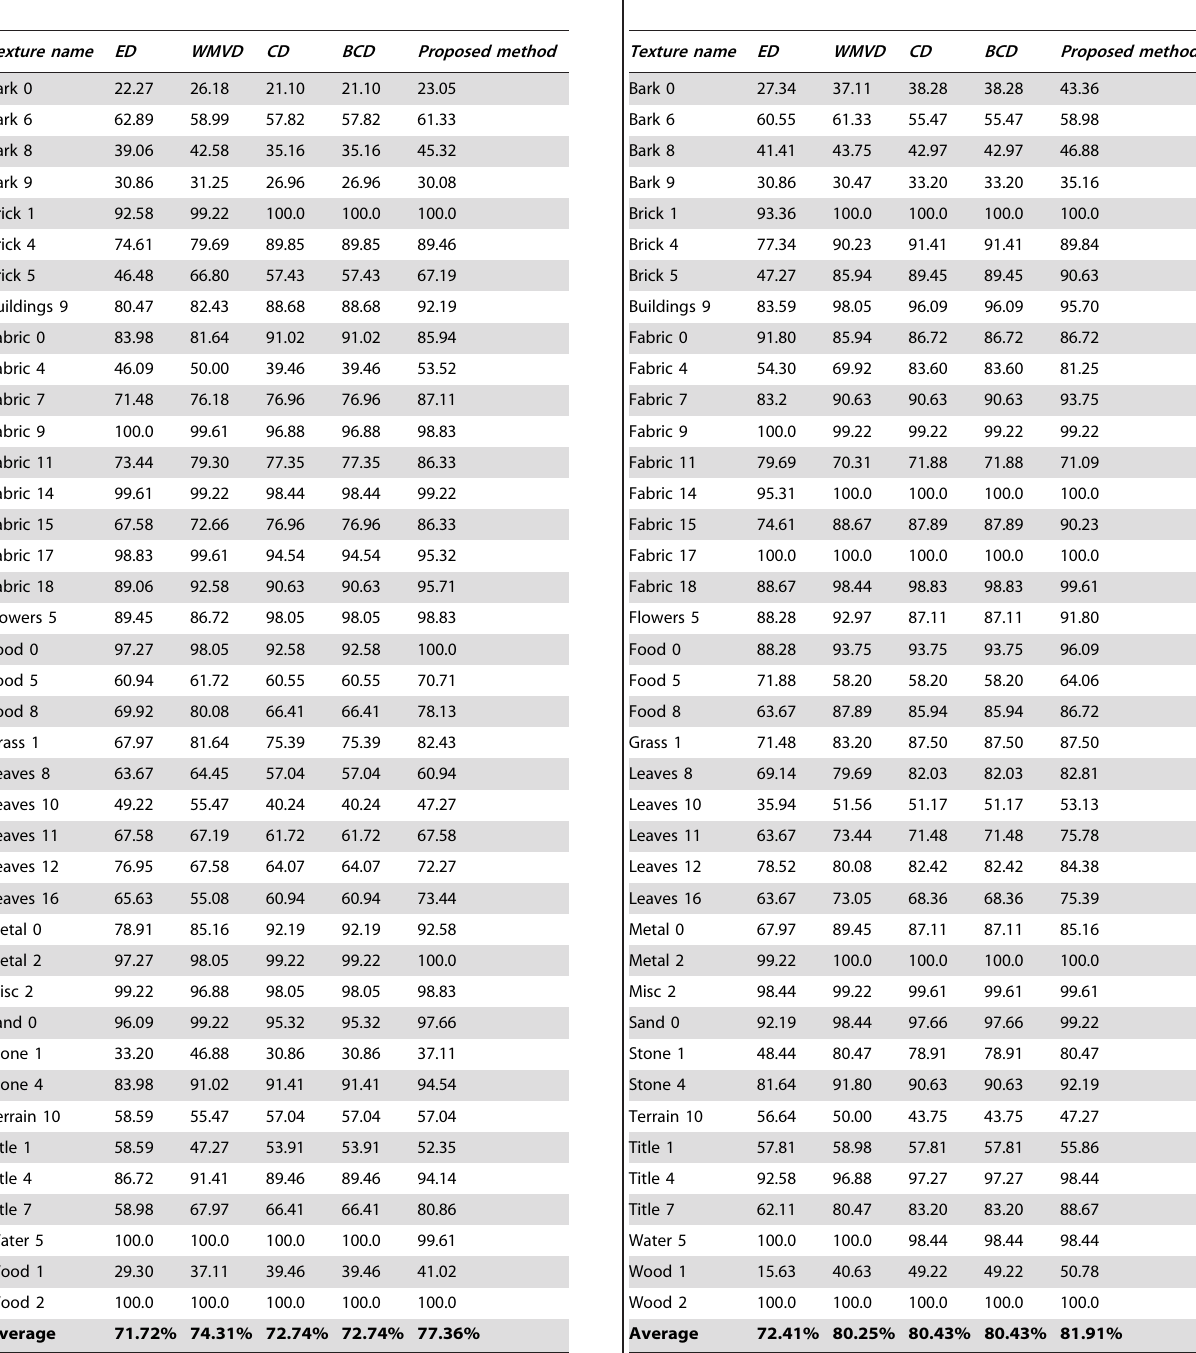
Table 1. Comparison of retrieval performance of different types of metrics for texture image retrieval using NSCT on the MIT image database (640 images of 40 different classes).